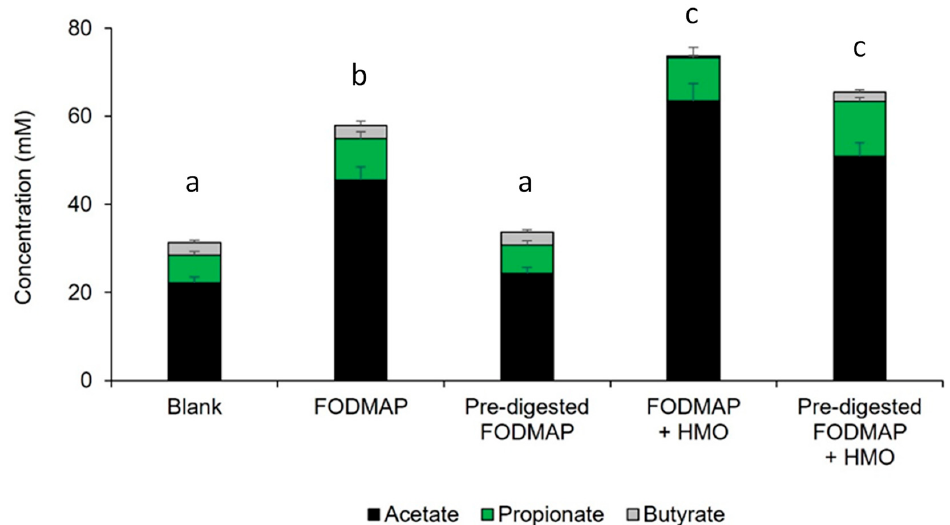
Figure 3. Changes in total SCFA, propionate, acetate, and butyrate in short-term colonic batch experiments (48 h). Total SCFA, propionate, acetate, and butyrate levels during different time intervals of colonic incubation are shown. Average ± SEM is shown across donors. Different letters represent statistically significant differences between the different test conditions with respect to total SCFA ( p < 0.05). The test substrates were as follows: FODMAP (0.86 g/L FOS + 0.21 g/L stachyose + 0.21 g/L raffinose + 1.71 g/L lactose), pre-digested FODMAP (0.05 g/L stachyose + 0.10 g/L raffinose + 0.11 g/L lactose), FODMAP + HMO (FODMAP composition + 2.4 g/L 2 ′ FL/DFL + 0.6 g/L lacto-N-neotetraose), pre-digested FODMAP + HMO (pre-digested FODMAP composition + 2.4 g/L 2 ′ FL/DFL + 0.6 g/L lacto-N-neotetraose). 2 ′ FL = 2 ′ fucosyllactose; DFL = difucosyllactose; FODMAP = fermentable oligosaccharides, disaccharides, monosaccharides, and polyols; HMO = human milk oligosaccharide; SCFA = short-chain fatty acid.